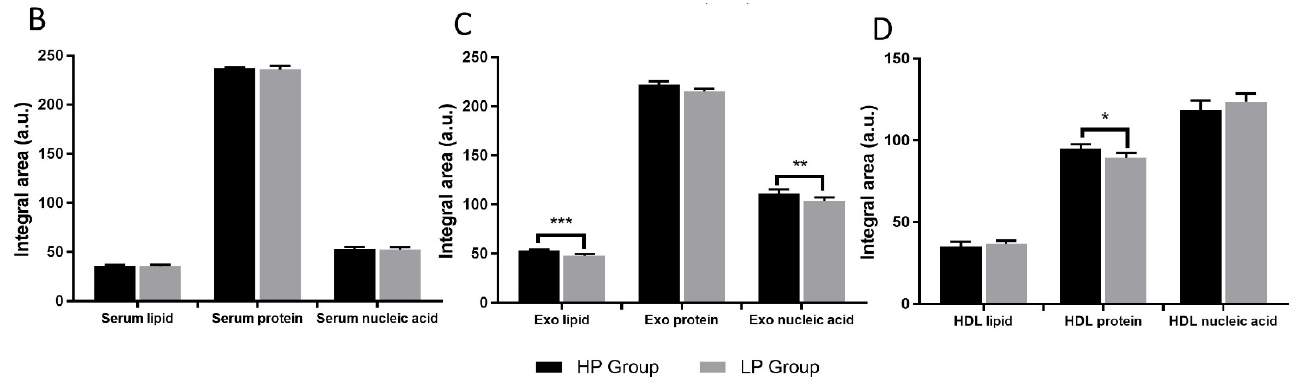
Figure 2. Results of spectral band area analysis of serum, exosome, and HDL spectra. Representative spectra from serum (blue), exosome (red), and HDL (green). Regions selected for the spectral band area analysis were 3000–2800 cm −1 lipid (orange region), 1700–1500 cm −1 protein (green region), and 1270–960 cm −1 nucleic acid (blue region) ( A ). The comparison of spectral band area between the LP and HP groups based on serum ( B ), exosome ( C ), and HDL spectra ( D ); * = p < 0.05; ** = p < 0.01; *** = p < 0.001.